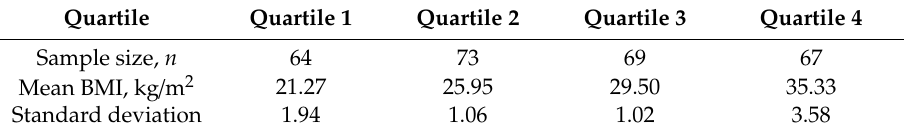
Table 2. Sample size, mean, and standard deviation of the BMI quartiles.